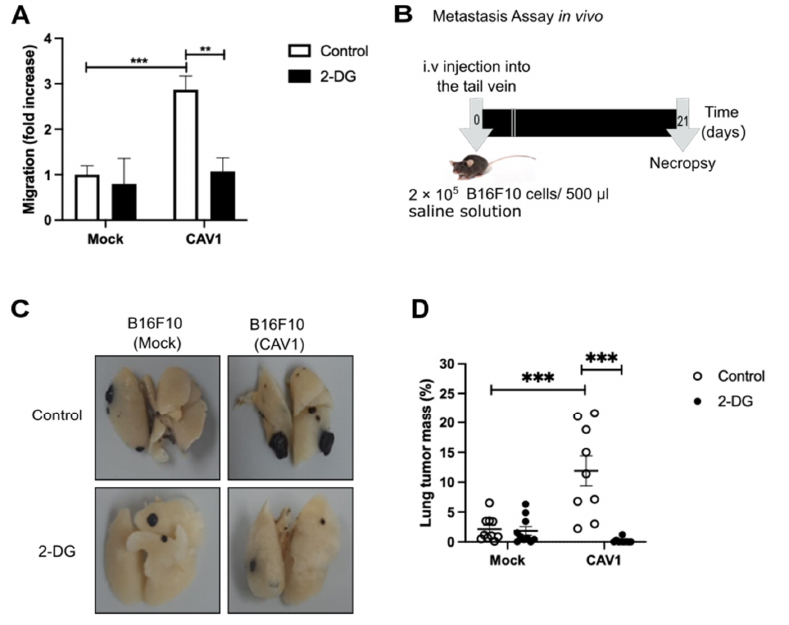
Figure 7. Inhibition of glycolysis reduces migration and metastasis. B16F10(Mock) and B16F10(CAV1) cells were treated for 24 h with 2-Deoxy-D-glucose (2-DG, 1 mM). ( A ) Cells (2 × 10 5 ) were seeded in Boyden chambers coated with fibronectin (2 μ g/mL) and allowed to migrate for 2 h. The cells that migrated through the pores were stained and counted. Values obtained were normal- ized to the control condition (Mock; on average 18 cells per field). ( B ) Schematic representation of the experimental design used for the metastasis assay. B16F10(Mock) and B16F10(CAV1) cells (2 × 10 5 ) were pre-treated for 24 h with 1 mM 2-DG and injected intravenously into the tail vein of C57BL/6 mice. After 21 days, mice were euthanized, lungs were fixed, and total lung and metastasis mass were determined. ( C ) Representative images of the lung metastasis in each condition are shown. ( D ) Average values (mean ± SEM) for lung occupation by tumors in C57BL/6 mice inocu- lated with B16F10(Mock) and B16F10(CAV1) cells, pre-incubated or not with 2-DG. Statistically sig- nificant differences are indicated (*** p < 0.001, ** p < 0.01; n = 10 animals per condition) .